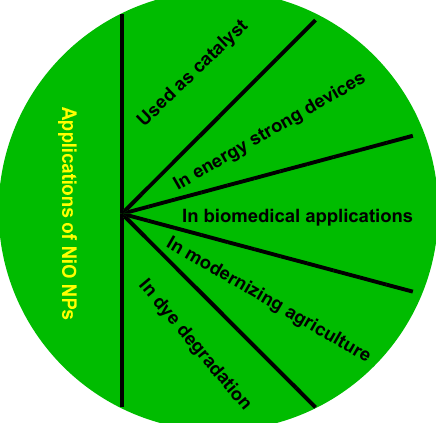
Antibiotics 2022 , 11 , x FOR PEER REVIEW Figure 2. Applications of NiO NPs [92,101,102]. Figure 2. Applications of NiO NPs [92,101,102].